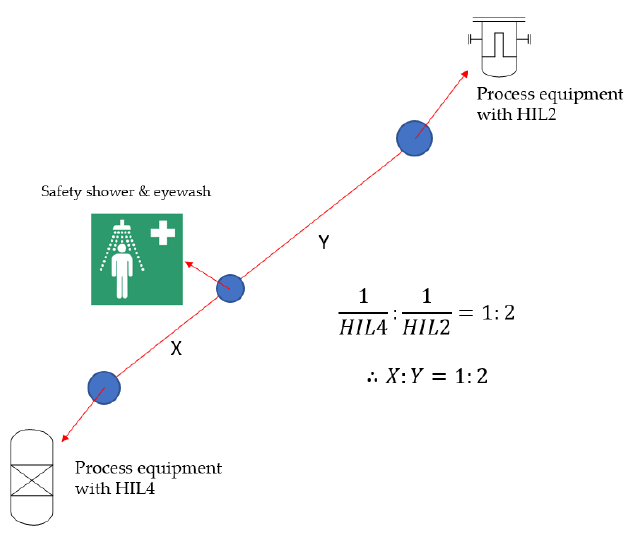
Figure 1. Example for efficient placement of safety shower and eyewash station.